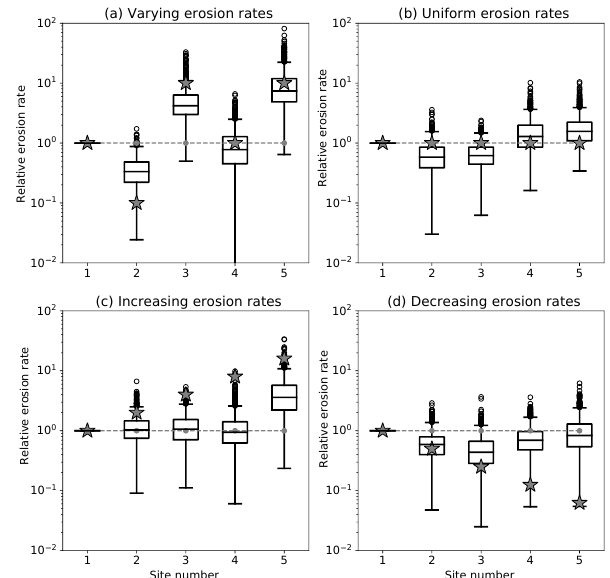
Figure 4. Results of the method applied to the second set of syn- thetic datasets with random peak amplitudes. See Fig. 3 caption for further details.